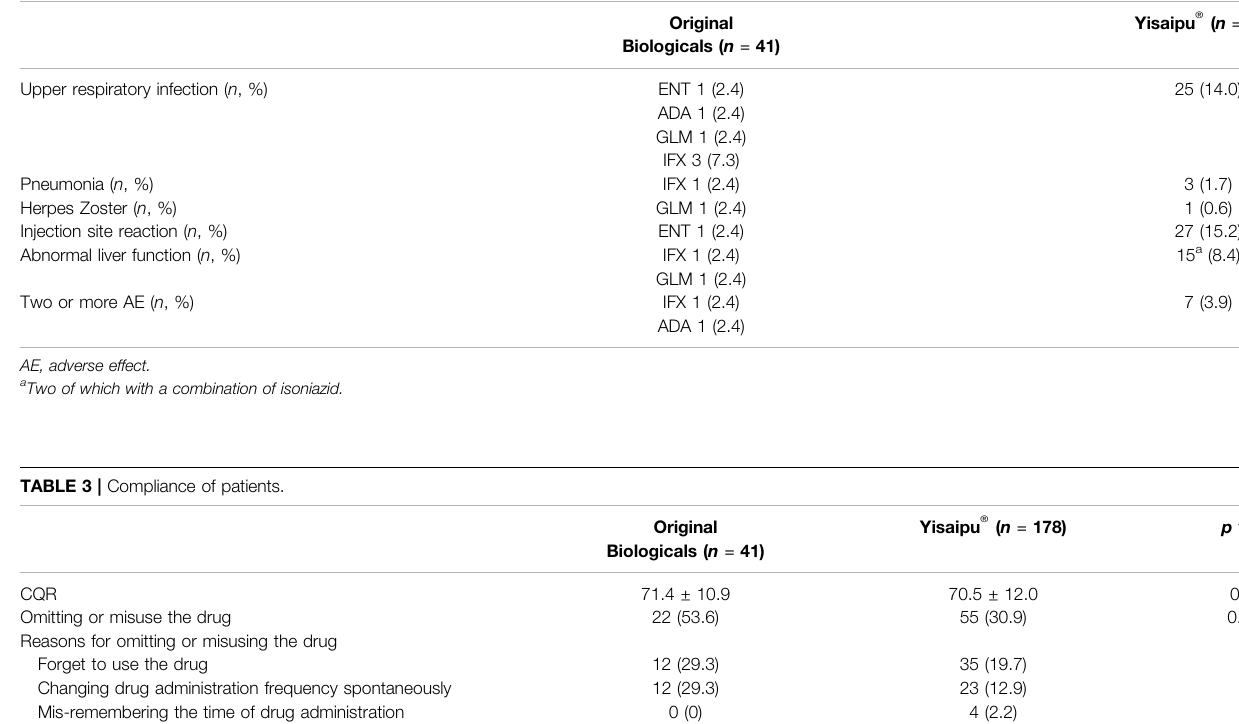
TABLE 2 | Adverse events of patients.